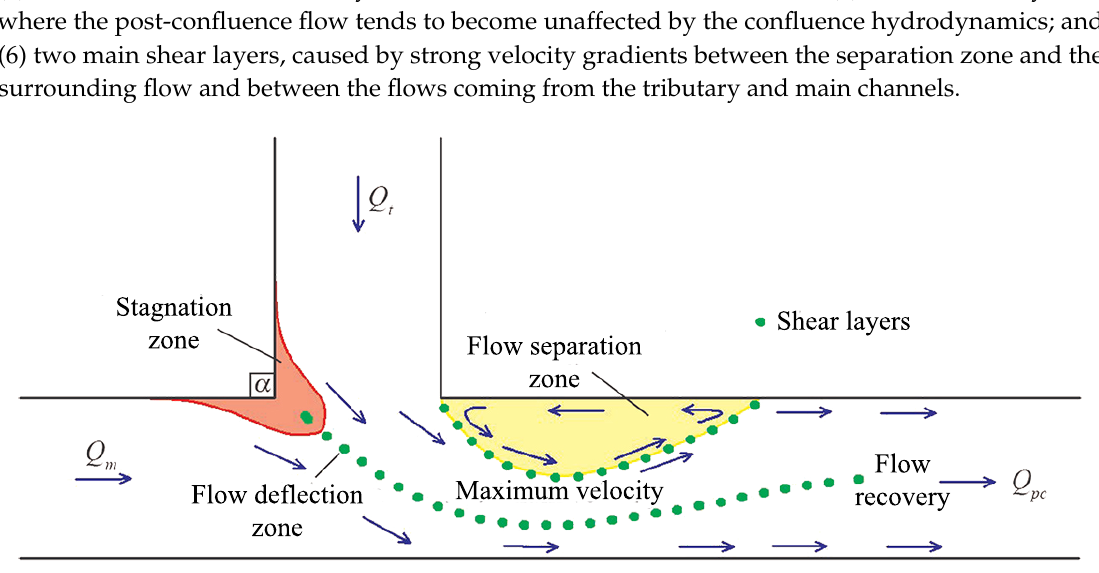
Figure 1. Conceptual model of flow dynamics at river confluences, modified from Best [1]. Q pc is the post-confluence discharge; α is the junction